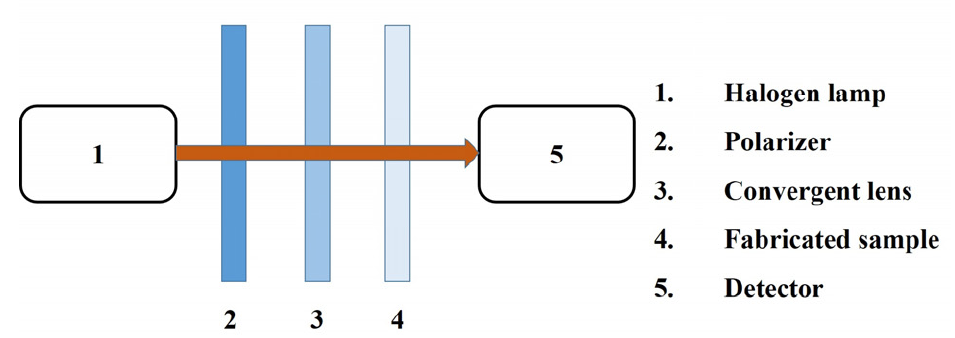
Figure 2. The schematic presentation of the convergent spectrometer with a polarizer.